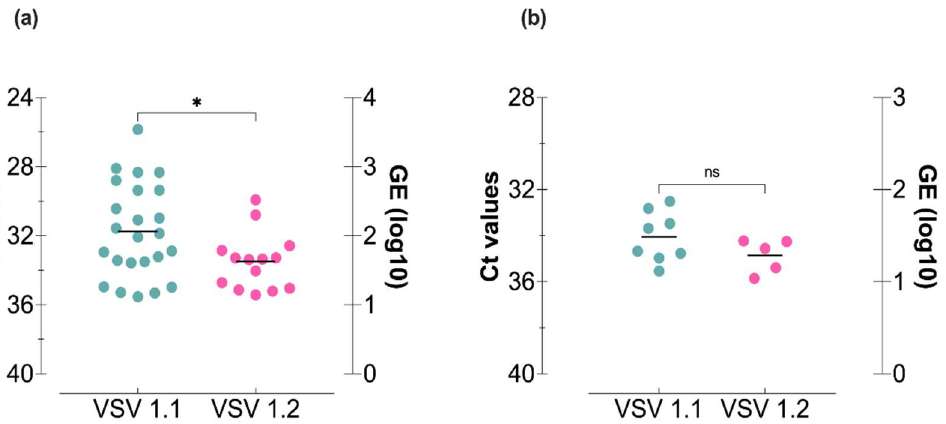
Figure 4. Culicoides midges orally infected with VSV epidemic lineage 1.1 (NJ0612NME6; teal) and the endemic lineage 1.2 (NJ0806VCB; pink) propagated in porcine epithelial cells. RT-qPCR cycle threshold (Ct; left Y-axis) and viral genome equivalents (GE; right Y-axis) in individual ( a ) bodies and ( b ) heads sampled 10 days after oral infection. Data were pooled from two biological replicates. Unpaired t-test was used to determine statistical significance as indicated ( n = 30 midges per lineage; p > 0.05, ns, not significant; * p ≤ 0.05). Table 1. VSV detection by CPE of orally infected Culicoides midges.